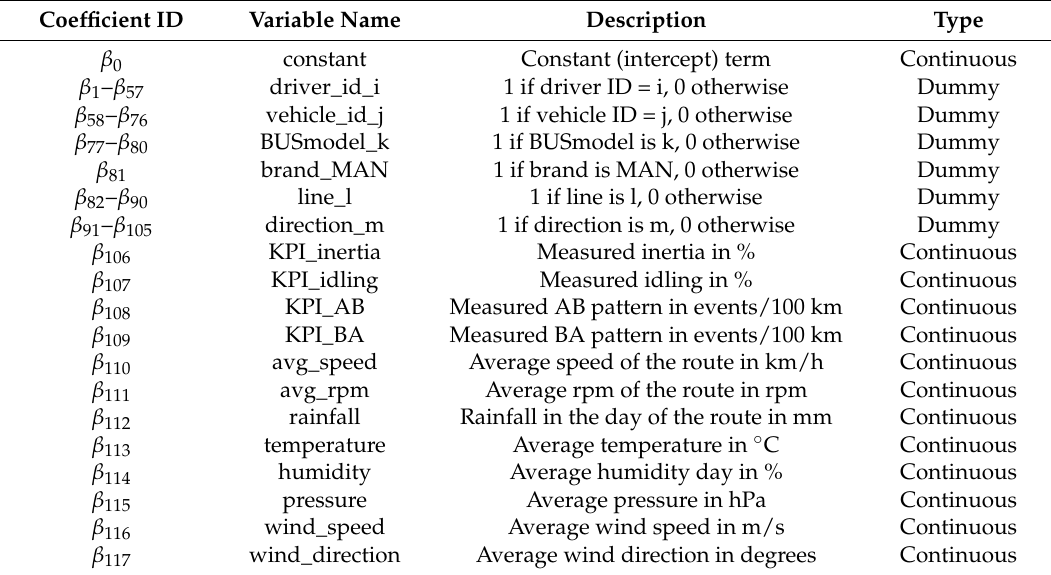
Table 5. Continuous and dummy variables in the